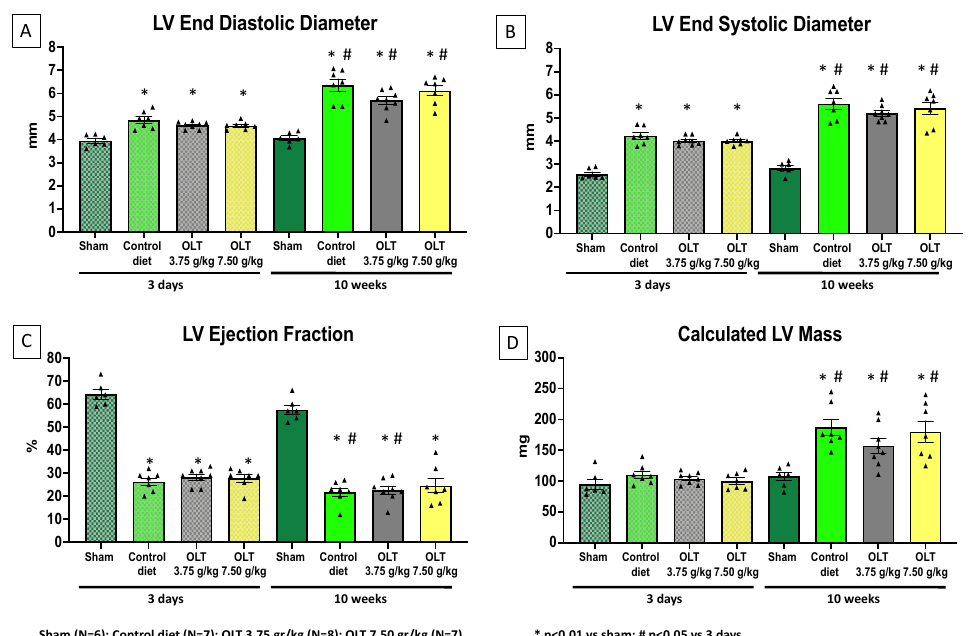
Figure 3. Effects of OLT1177 on left ventricular function and remodeling. The echocardiographic results at 3 days and 10 weeks post-MI surgery indicate that no significant differences were reported between the control group and both OLT-treated groups. ( A , B ) LVEDD and LVESD significantly increased in the control group and the OLT-treated mice. ( C ) The LVEF values recorded show a significant reduction in the control group and the OLT-treated mice. ( D ) The LV mass of the control group and of both OLT-treated groups also show a significant increase throughout the study. Each triangle corresponds to the value measured in each mouse. The values are expressed as the mean ± SEM. the LV at rest compared to stress. In our study, it was measured as the percent change in LVEF after the isoproterenol challenge. Ten weeks after MI, the mice fed with low- or high-dose OLT1177 ® diet (Groups 1 or 2) displayed significantly greater preservation of their contractile reserve than the mice fed with the control diet (Group 3) (+33 ± 11% or +40 ± 6%, respectively, versus +9 ± 7%, p = 0.034, and p = 0.002), while also displaying no significant difference from the sham-operated mice (Group 4) (+28 ± 4%, p = 0.750, and p = 0.117) (Figure 4). No difference was noted between the groups fed with the two active diets.